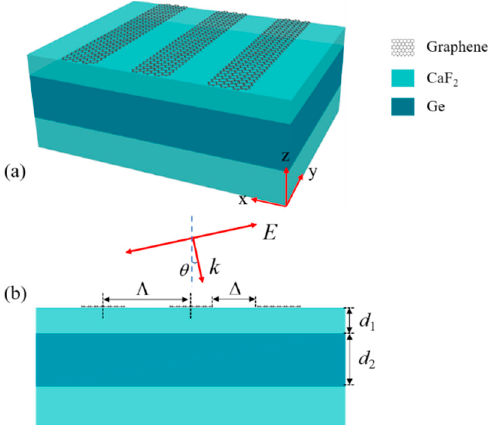
Figure 1. ( a ) Schematic diagram of designed structure. ( b ) Cross-sectional view of the structure in Figure 1a.